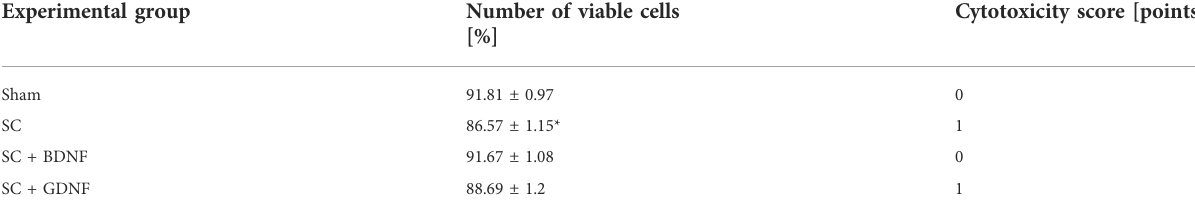
TABLE 2 Cytotoxicity analysis of scaffolds for primary hippocampal cultures on day 14 of development in vitro . Experimental group